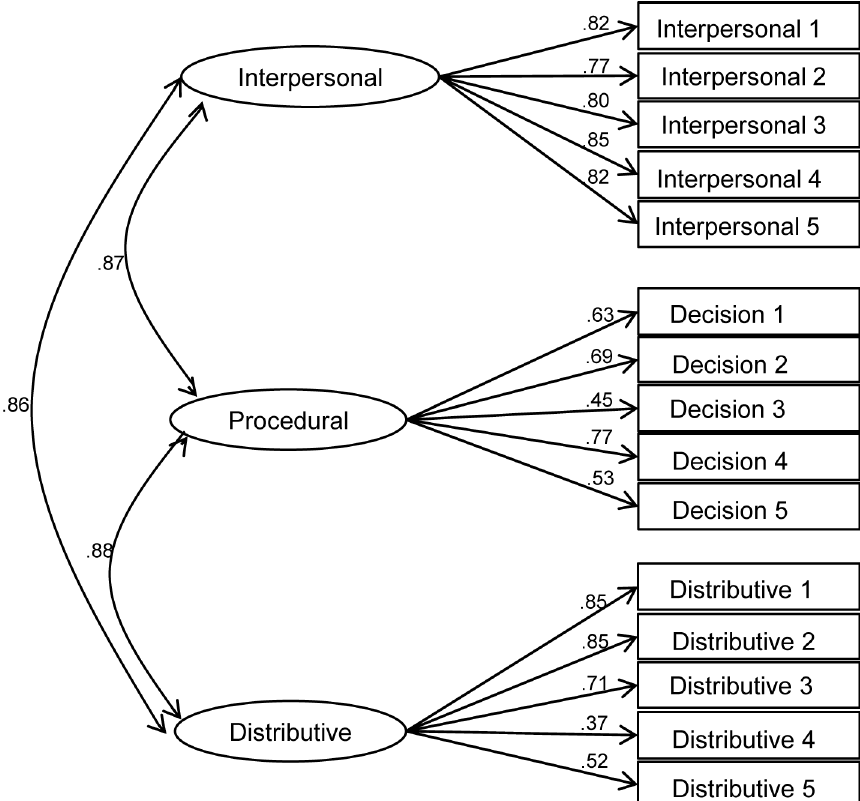
Fig 5. Three-factor model of police fairness (interpersonal respect, fair decisions and distributive fairness; model D).